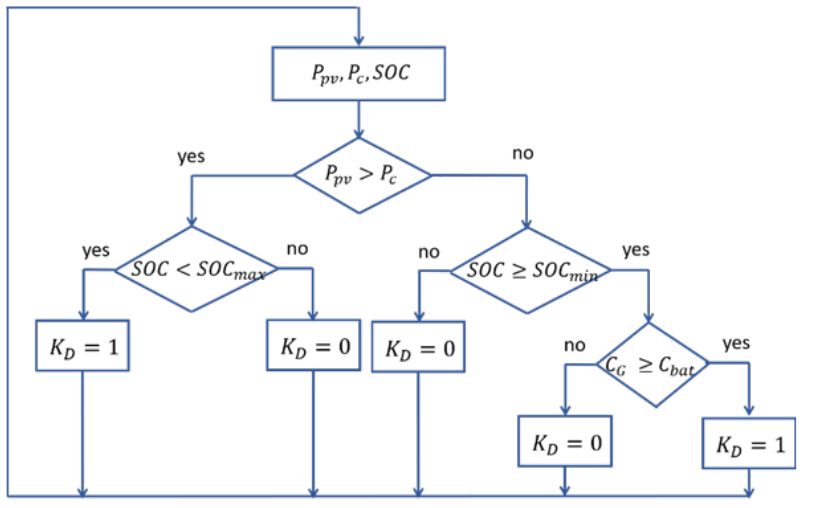
Figure 8. Flowchart of the strategy 2.